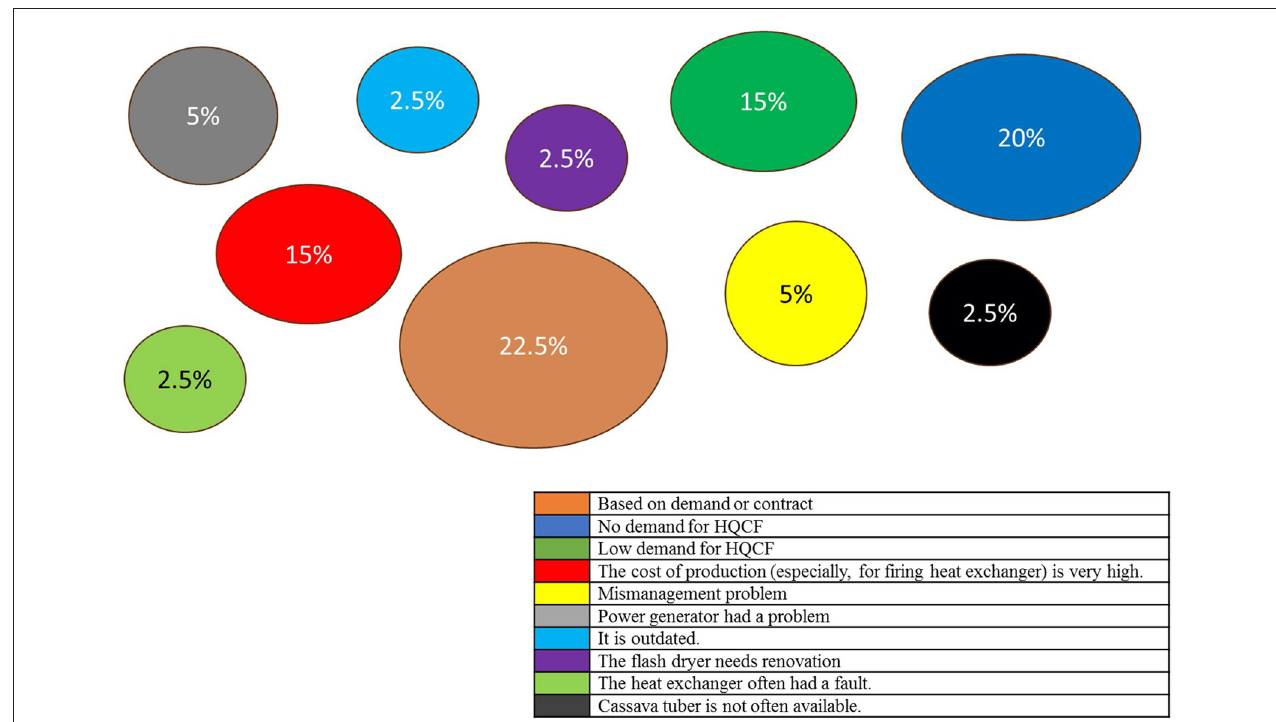
FIGURE 4 | Reasons for the non-use (or occasional usage) of flash dryers.